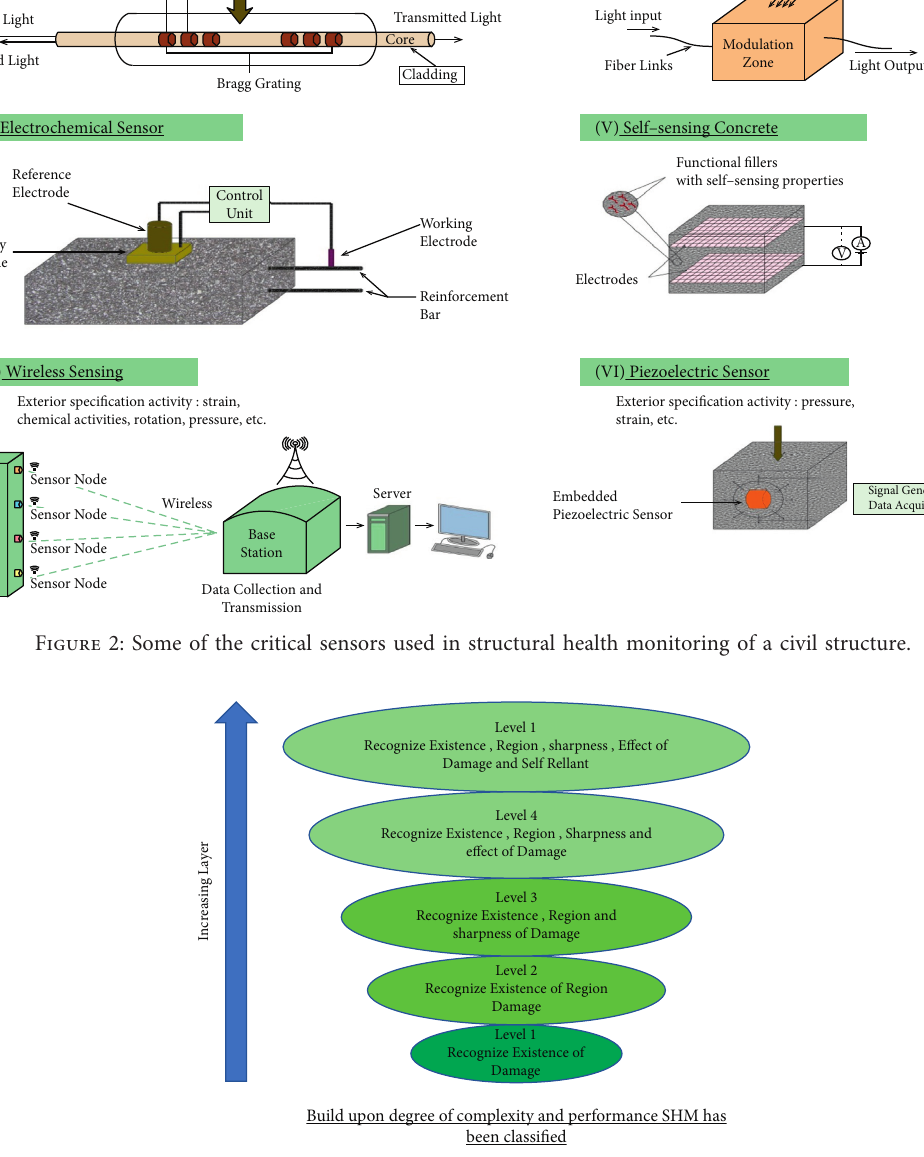
Figure 3: Levels of detecting damage in